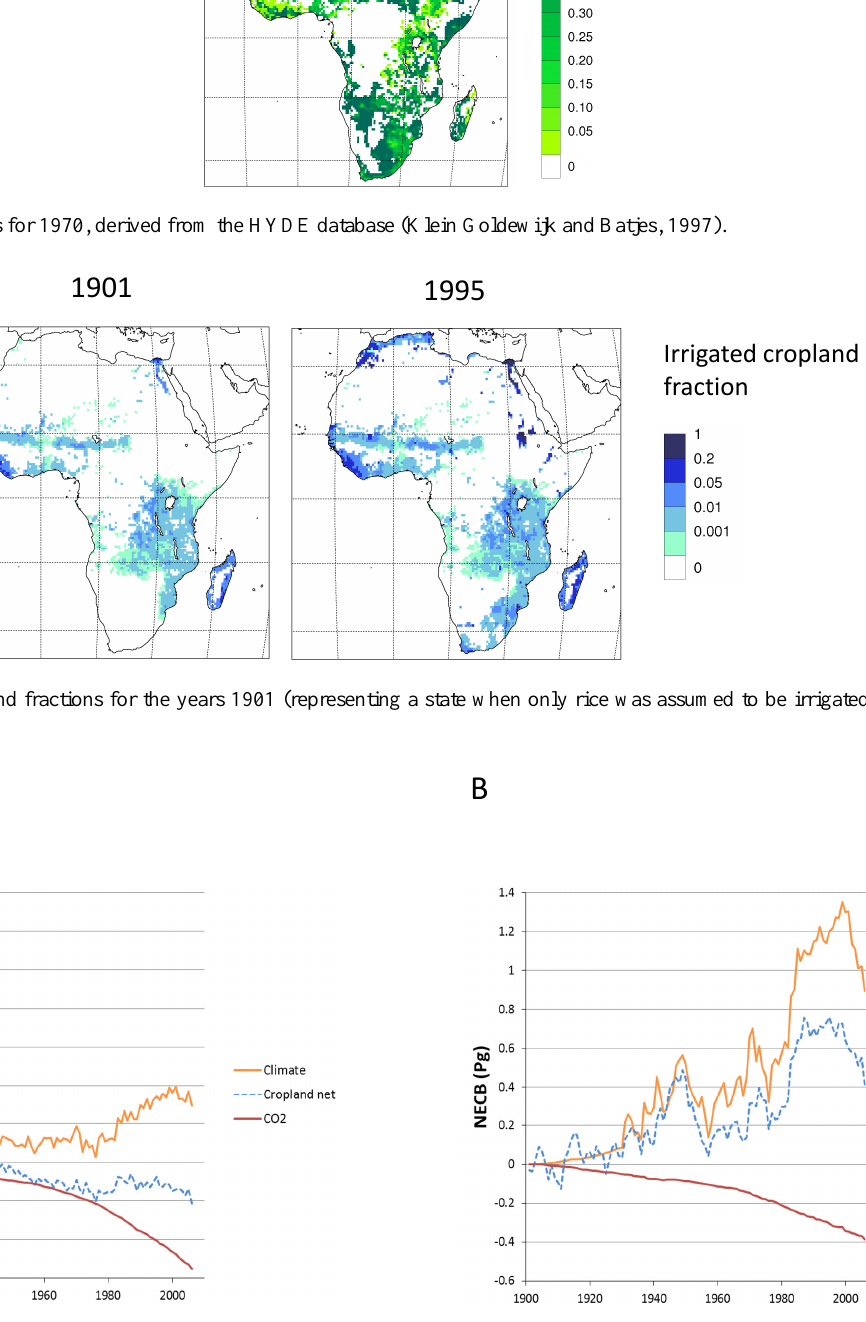
Fig. B1. Separate contributions of CO 2 and climate change to the modelled 1901–2006 cumulative net ecosystem carbon balance (NECB) for cropland (A) and pasture (B) of the African continent, derived by comparing a simulation (S1, “net” in this figure) forced by historical CO 2 , climate and land use with separate simulations where either CO 2 or climate was kept at the spin-up levels throughout the simulation period. Positive values represent a flux to the